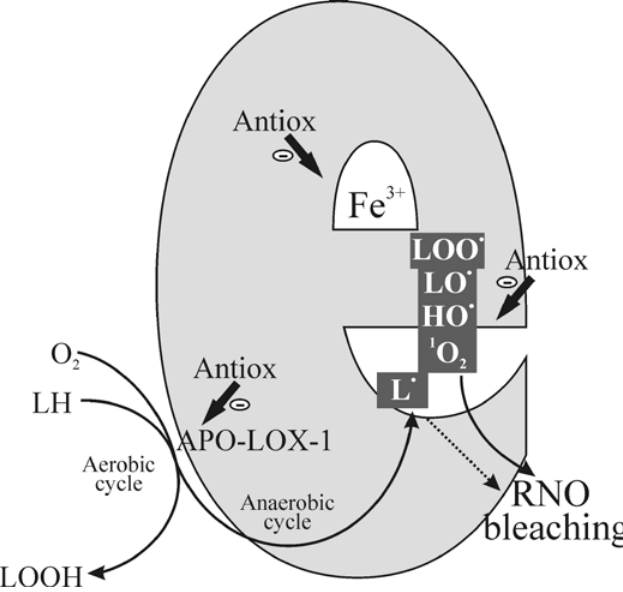
Fig. 1 - Schematic representation of the aerobic and anaerobic cycles catalyzed by the soybean lipoxygenase (LOX)-1 isoenzyme in- volved in the bleaching of the 4-nitroso- N,N- dimethylaniline (RNO). The soybean LOX-1 apoenzyme is represented as e- shaped and Fe 3+ indicates non-heme iron atom essential for the LOX-1 catalysis. The aerobic cycle of soybean LOX-1-mediated hydroperoxidation of linoleic acid (LH) is schematized, as well as secondary anaerobic reactions involving generation of radical species, able to induce the RNO bleaching. The short black ar- rows indicate some different mechanisms by which antioxidant compounds may inhibit the LOX-1-dependent RNO bleaching. Antiox, antioxidant compounds; LO • , LOO • , L • , alkoxyl, peroxyl and alkylic radicals of LH; LOOH, 13-hydroperoxy derivative of LH; 1 O , singlet oxygen; • OH, hydroxyl 2